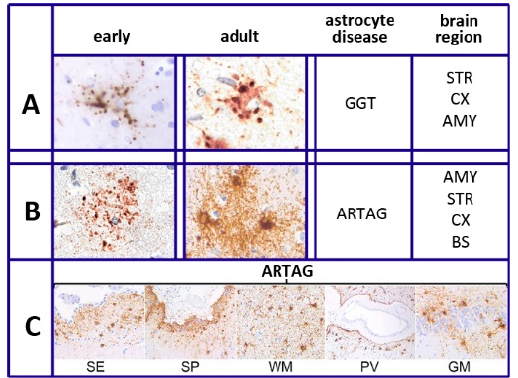
Figure 1. Tau heterogeneity and pathology of various astrocytes. ( A , B ) show the tau deposition of globular-glial tauopathies (GGT) and aging-related tau astrogliopathy (ARTAG), presented as early (left columns) and adult (right columns) morphologies. Brain regions of GGT and ARTAG distribution are listed on the right: AMY = amygdala; STR = striatum; CX = cortex; BS = brainstem. ( C ): thorn-shaped astrocytes of ARTAG type distributed at subependymal (SE), subpial (SP), white matter (WM), perivascular (PV), and rare gray matter (GM) location. Reproduced in part with